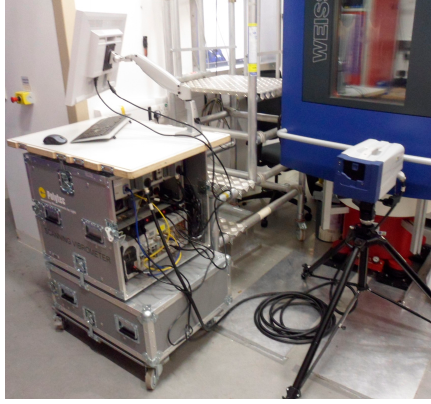
Figure 7. Polytec PSV-500 XTRA laser vibrometer scanning system.